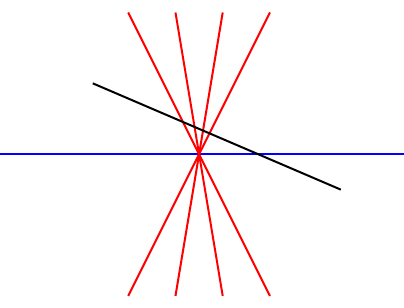
Figure 8 . The gauge 7-branes of E 6 algebra are on top of each other and denoted by the red line. The four red lines denote the four I ’s which are obtained from solving the equation ˜∆ = 0 with 1 respect to g . The black line segment denotes a disk D that intersects the 12 7-branes. 4